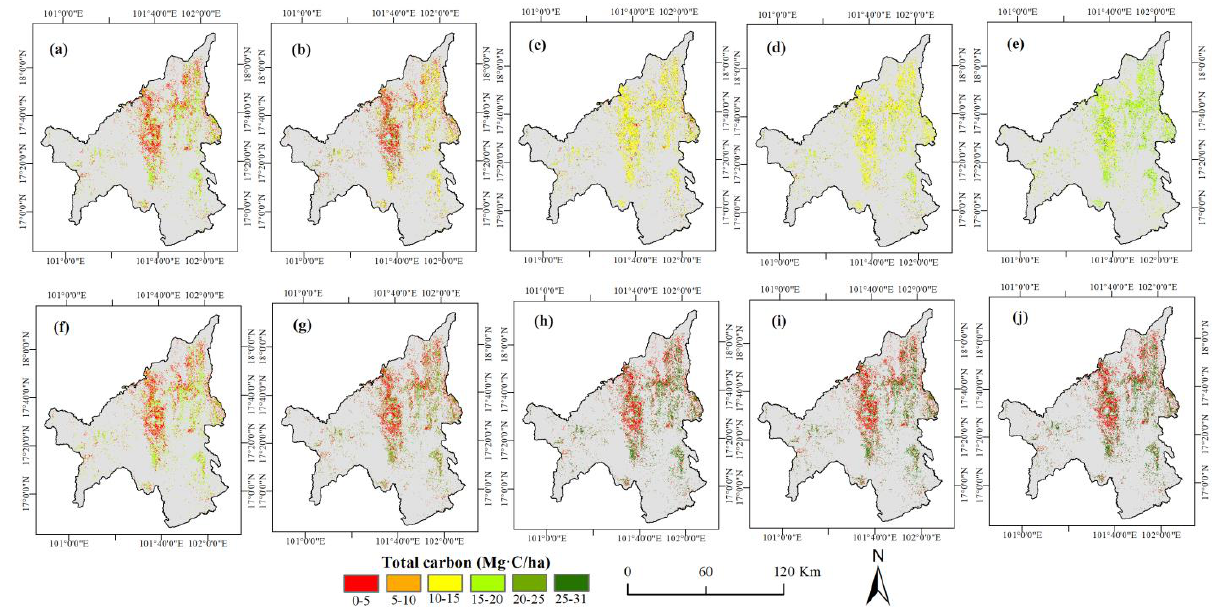
Figure 8. Spatial and temporal pattern distribution of carbon density in Loei Province (where ( a – e )/( f – j ) correspond to 1999, 2004, 2009, 2014, and 2018, respectively; ( a – e ) and ( f – j ) represent the scenarios under actual rubber plantations and hypothetical non-rubber plantations, respectively).